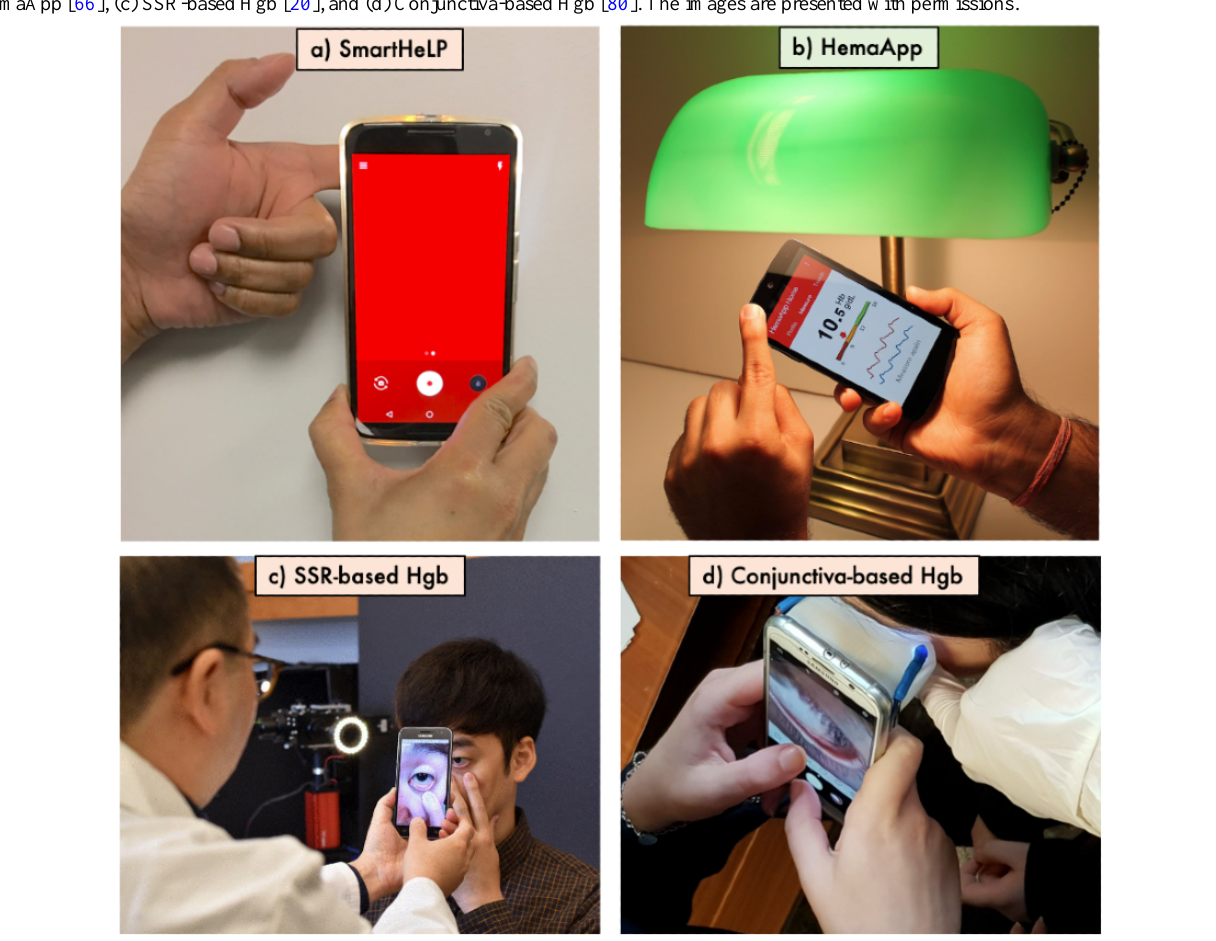
Figure 4. Smartphone-based point-of-care tools for noninvasive hemoglobin measurement using fingertip and eyelid images. (a) SmartHeLP [53],